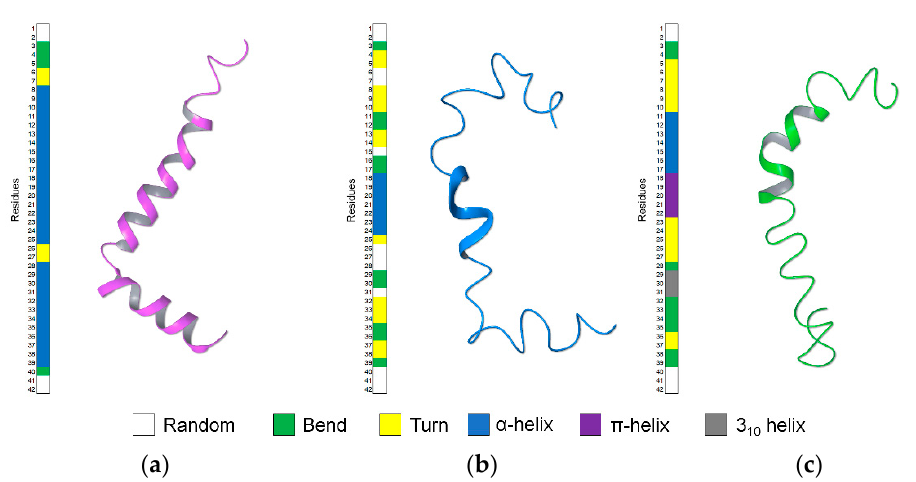
Figure 7. Comparison of the A β (1–42) structures in the different solvent system of HFIP/water v/v , ( a ) 80/20 (PDB ID: 1IYT); ( b ) 50/50 (PDB ID: 6SZF); ( c ) 30/70 (PDB ID: 1Z0Q).